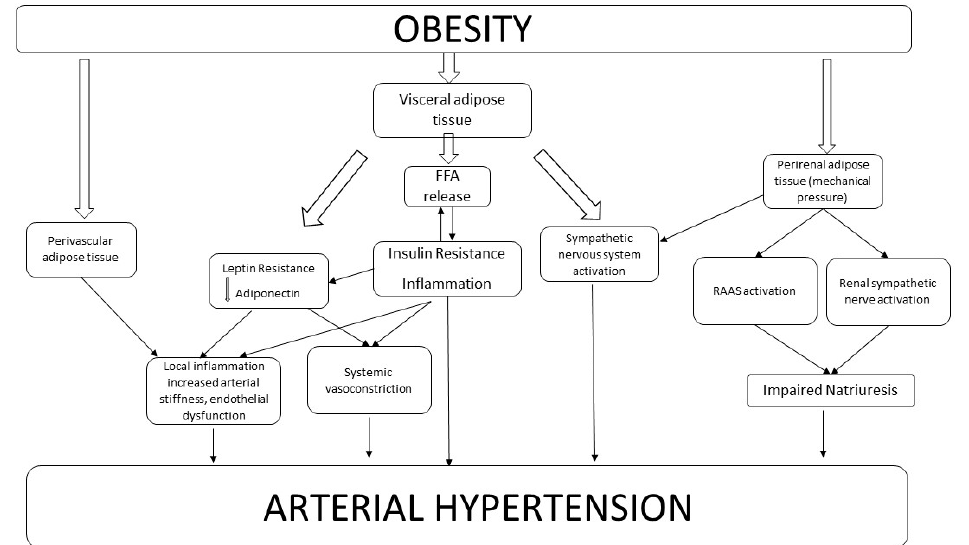
Figure 1. Mechanisms Linking Obesity to Hypertension.